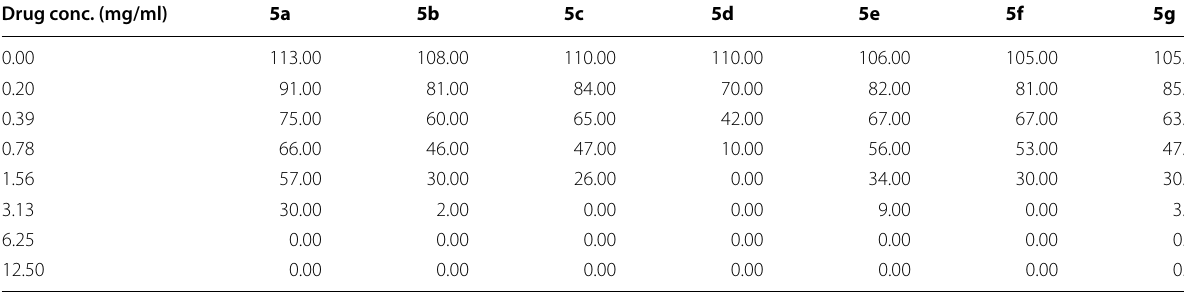
Table 2 Number of alive schizont at different concentrations of compounds 5a–5g Drug conc. (mg/ml) 5a